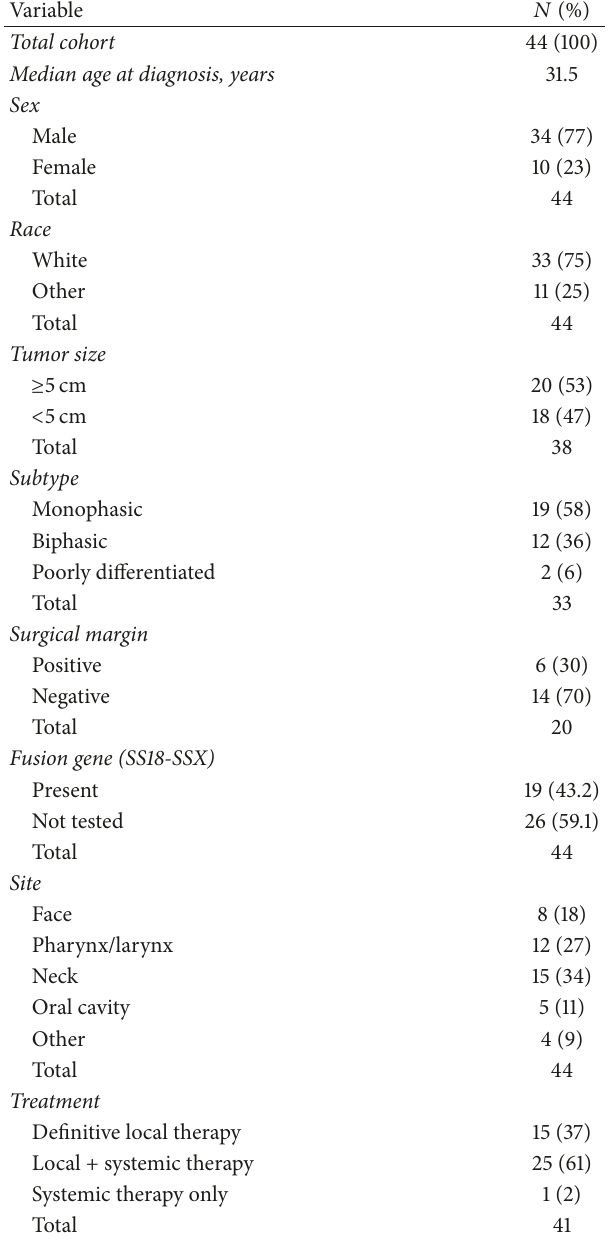
Table 1: Patient